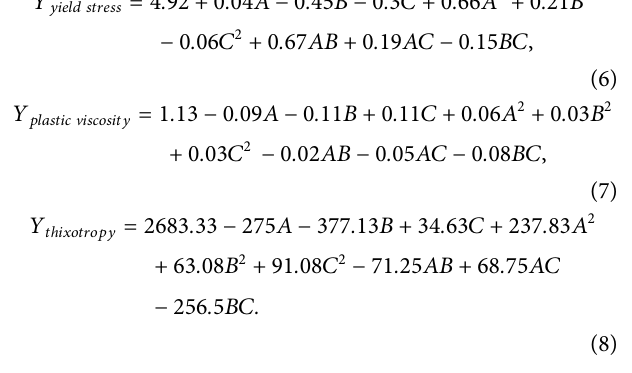
Frontiers in Materials |